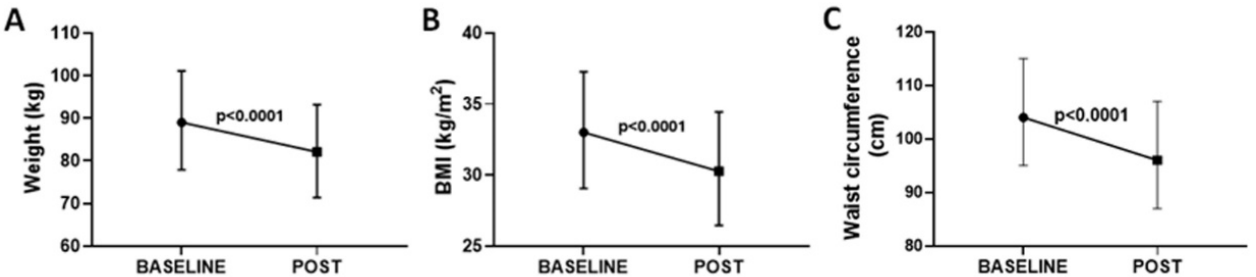
Figure 2 shows the results concerning the weight (Figure 2A), BMI (Figure 2B), and waist circumference (Figure 2C) in all participants enrolled in the present study. In general, after the first 5 weeks of the 4 Phases Method application, significant reductions in these parameters were found ( p < 0.0001, in Figure 2A, − 7.68 ± 1.13 kg with ES = 0.32; in Figure 2B, − 2.28 ± 0.33 BMI with ES = 0.36; in Figure 2C, − 6.10 ± 2.69 cm with ES = 0.3). After 5 weeks of the 4 Phases Methodology, at least fifty percent of the subjects who took part in this methodology showed a decrease in one level of BMI (see Supplementary Material).